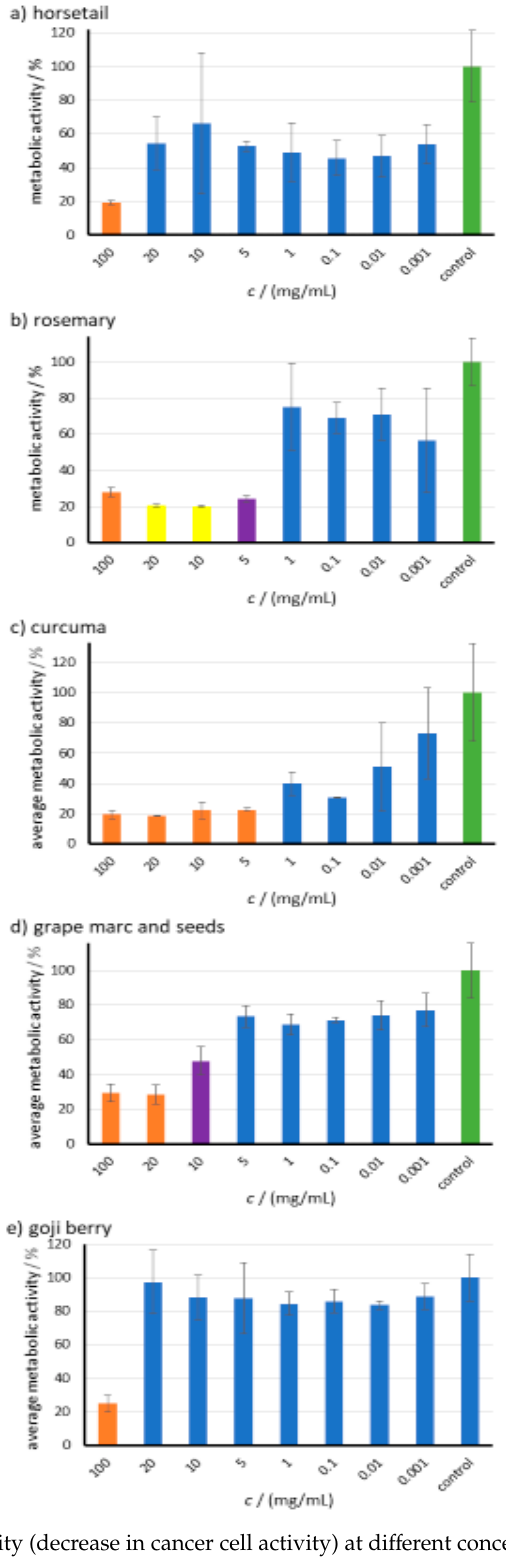
Figure 3. Metabolic activity (decrease in cancer cell activity) at different concentrations of ( a ) curcuma, ( b ) goji berry, ( c ) grape marc and seed, ( d ) horsetail, and ( e ) rosemary.